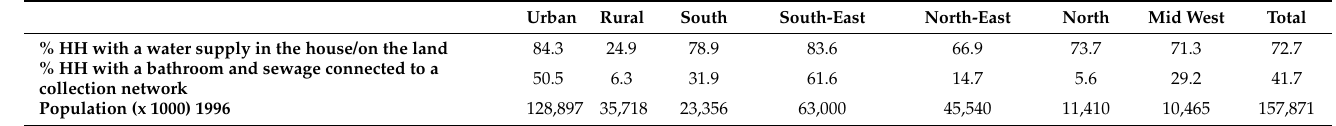
Table 1. Percentage of households with a water supply and sanitary sewage connection from Brazil’s MIC3 (1996) [18] and from IBGE 2010 (https://sidra.ibge.gov.br/, accessed on 30 September 2022). HH =